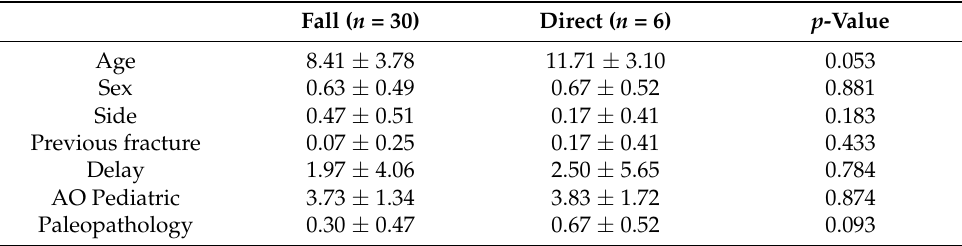
Table 5. Means, standard deviation, and p -value when comparing groups of the patients that suffered from a fall with patients that suffered from a direct